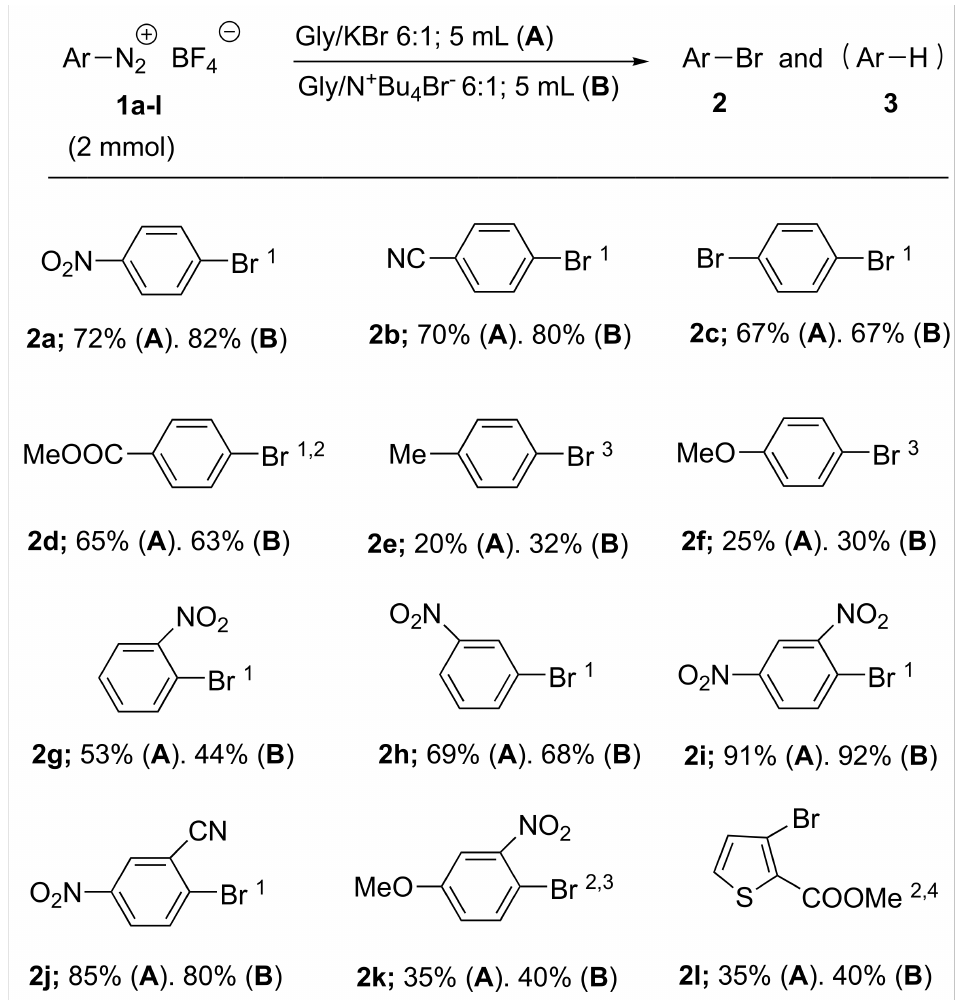
Figure 1. Bromodediazotation scope. 1 Reactions were carried out at room temperature for 4 h: 2 mmol of salts 1 and 5 mL of Gly/KBr (method A) or 5 mL of Gly/TBAB (method B). Longer